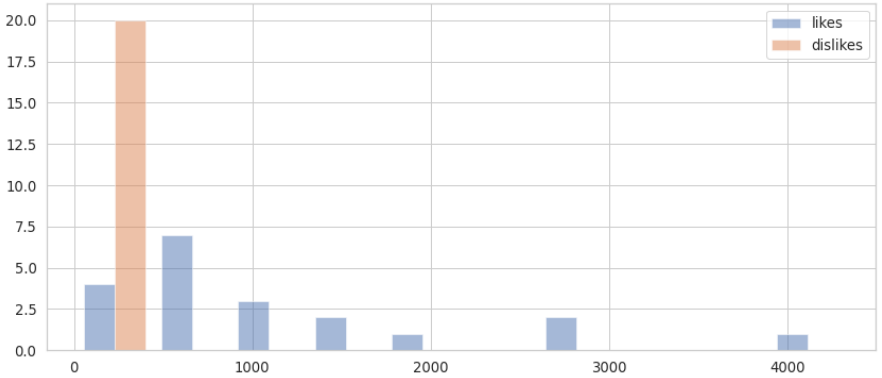
Figure 5. Histogram of likes and dislikes for the top 20 disliked BitChute